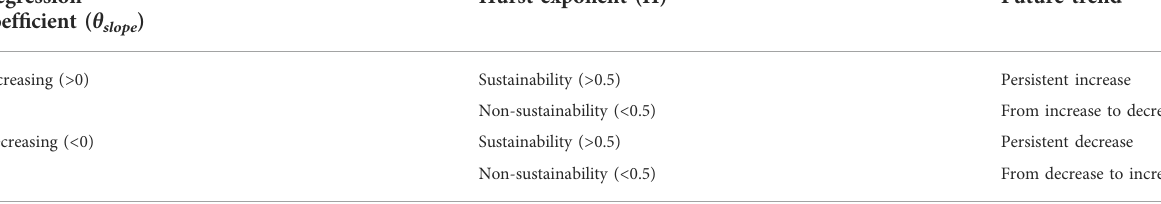
TABLE 2 Future trend characteristic.